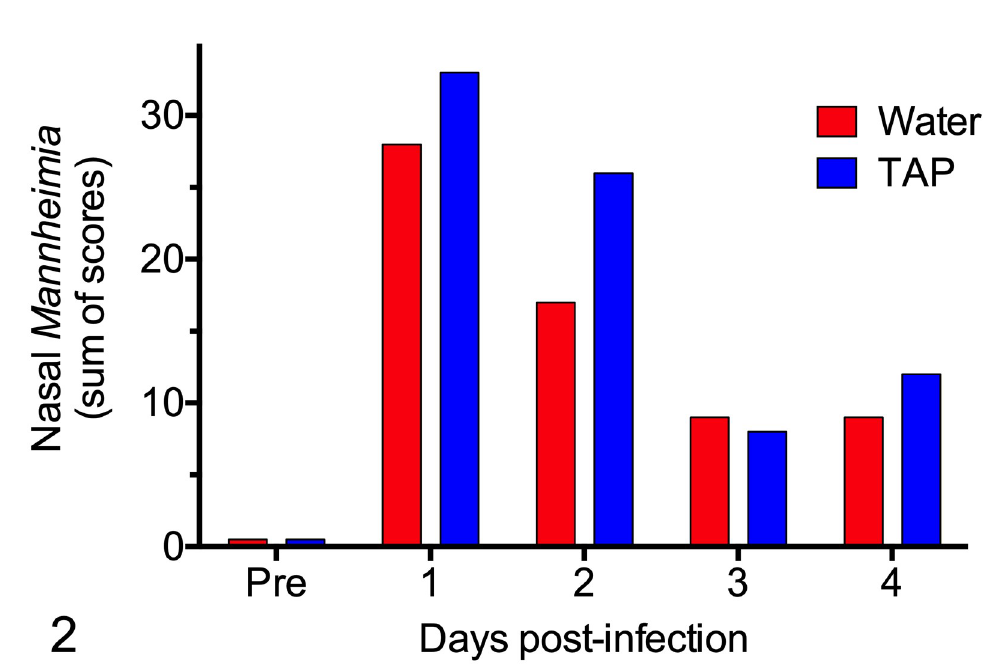
Fig 2. Isolation of Mannheimia haemolytica from right and left nasal cavities following challenge. Six pairs of calves were challenged with M . haemolytica B158 and treated with tracheal antimicrobial peptide (TAP) or water at 0.3, 2 and 6 hours after infection. Right and left nasal swabs were taken daily and the number of isolated M . haemolytica colonies was scored as 1, 2, 3 or 4 (maximum score of 8 for each calf). The data show the sums of scores across time for each group. The number of surviving calf pairs on each day are: n = 6 at 1 day post-infection, n = 5 at 2 days, n = 4 at 3 days, n = 3 at 4 days.